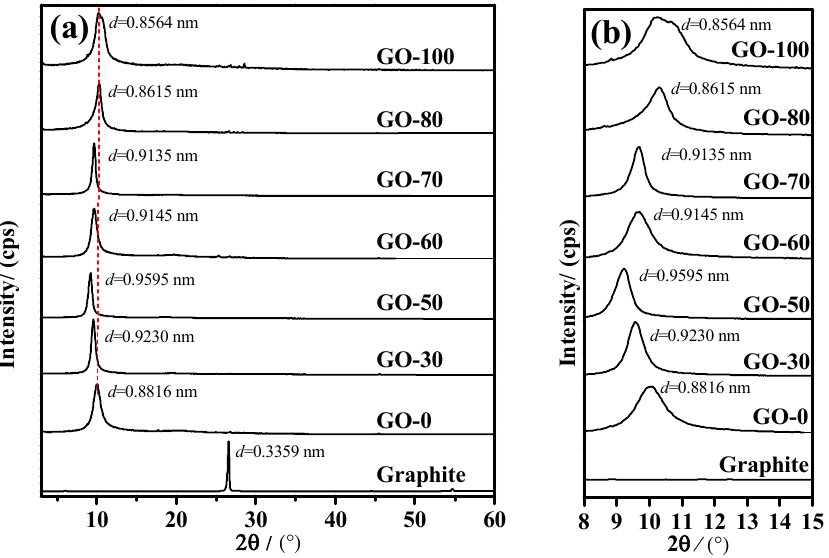
Figure 4. XRD patterns of graphite oxide samples prepared at different reaction temperatures: ( a ) XRD pattern between 3–60°, ( b ) XRD diffraction pattern between 8–15°.